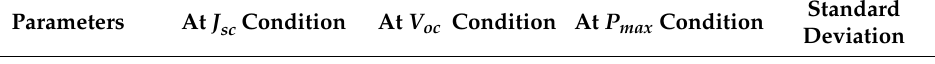
Table 2. Simulated values of each factor which influence the operating temperature of the OSC at J sc , V oc , and P max